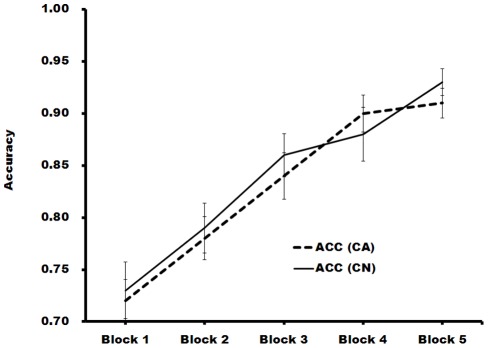
Accuracies of own- and other- race face recognition as a function of trial blocks.